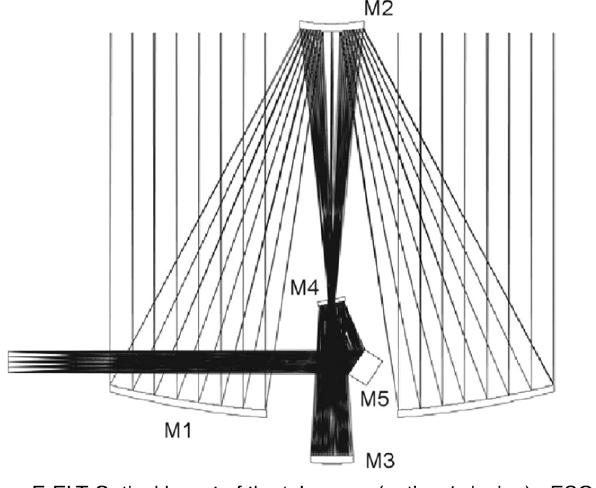
Figure 21: Optical design of the 5-mirror Extremely Large Telescope (ELT/ESO). The input pupil is the primary mirror M1, segmented aperture diameter 39 m. The pupil transfer is achieved closely to M4 and M5 mirrors which are either side of them. A field stabilization (FS) mirror and a multimode de formable mirror (DM) will be built for the M4 and M5 mirrors or conversely (courtesy